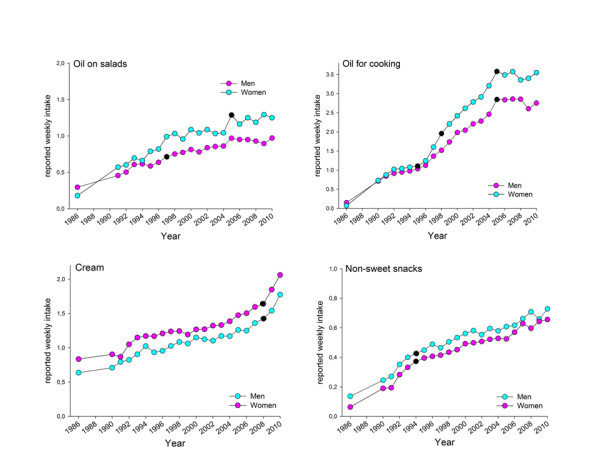
Reported mean intake of various types of oils used for salad dressing or cooking, cream and cream products, and non-sweet snacks. Reported weekly mean intake frequencies, adjusted for age and BMI for the period 1986 to 2010 for men and women. Information was not available for 1987 and 1988 since the VIP FFQ was not fully harmonized until 1991. Black dots (●) show years with a trend shift as indicated by the Joint Point software.